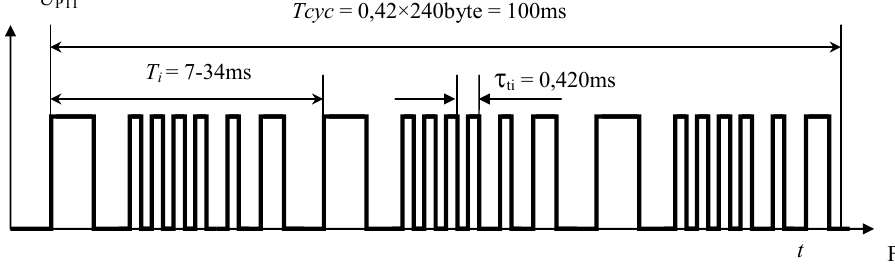
Fig. 8. A fragment of the information